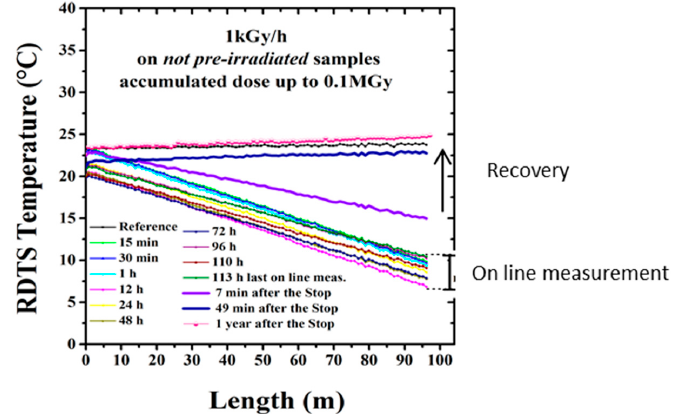
Figure 17. Distributed temperatures measurement performed, on Fiber I. Results obtained both during and after the γ -irradiation at 1 kGy(SiO 2 )/h dose rate. The red line indicates the first measurement from the start (our reference) and the dot line designates the room temperature (RT) at the beginning of the irradiation run. Copyright IEEE 2015.